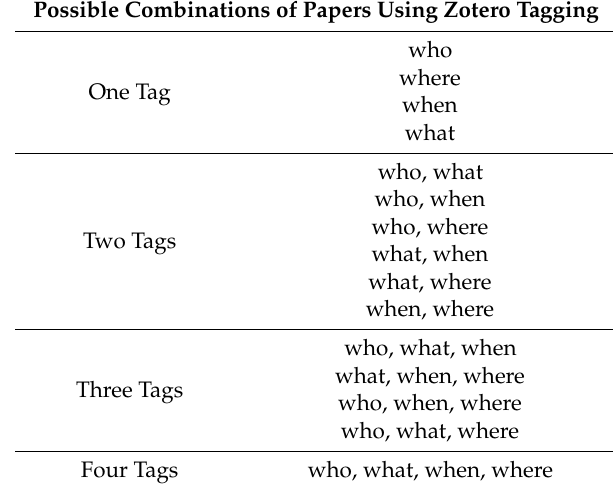
Table 4. Possible Combinations of Papers Using Zotero Tagging.